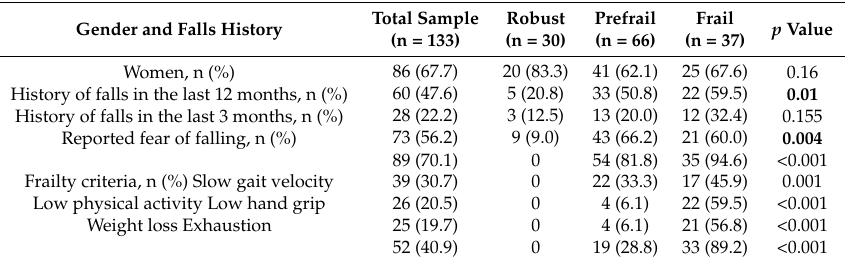
Table 2. Gender, falls history and frailty